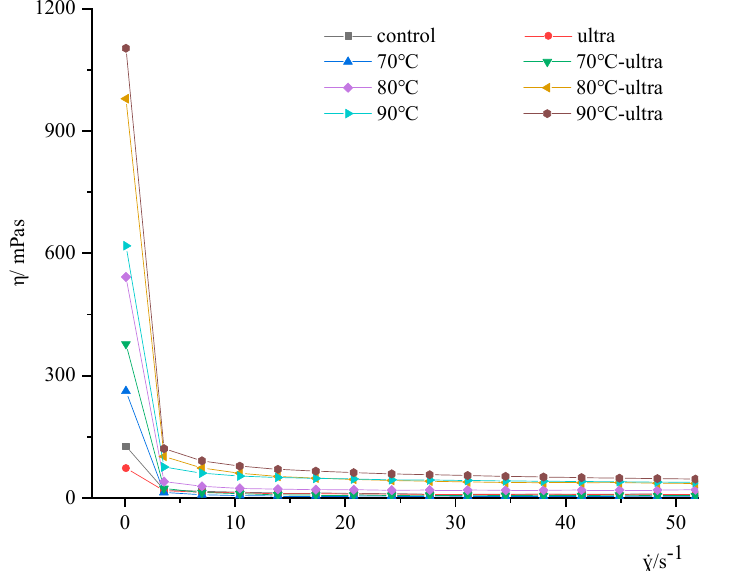
Figure 9. Rheological properties of different coconut milk samples before and after thermal (ultra: 53 kHz, 40 w / l , 20 min; 70, 80 and 90 °C represent preheating for 20 min).